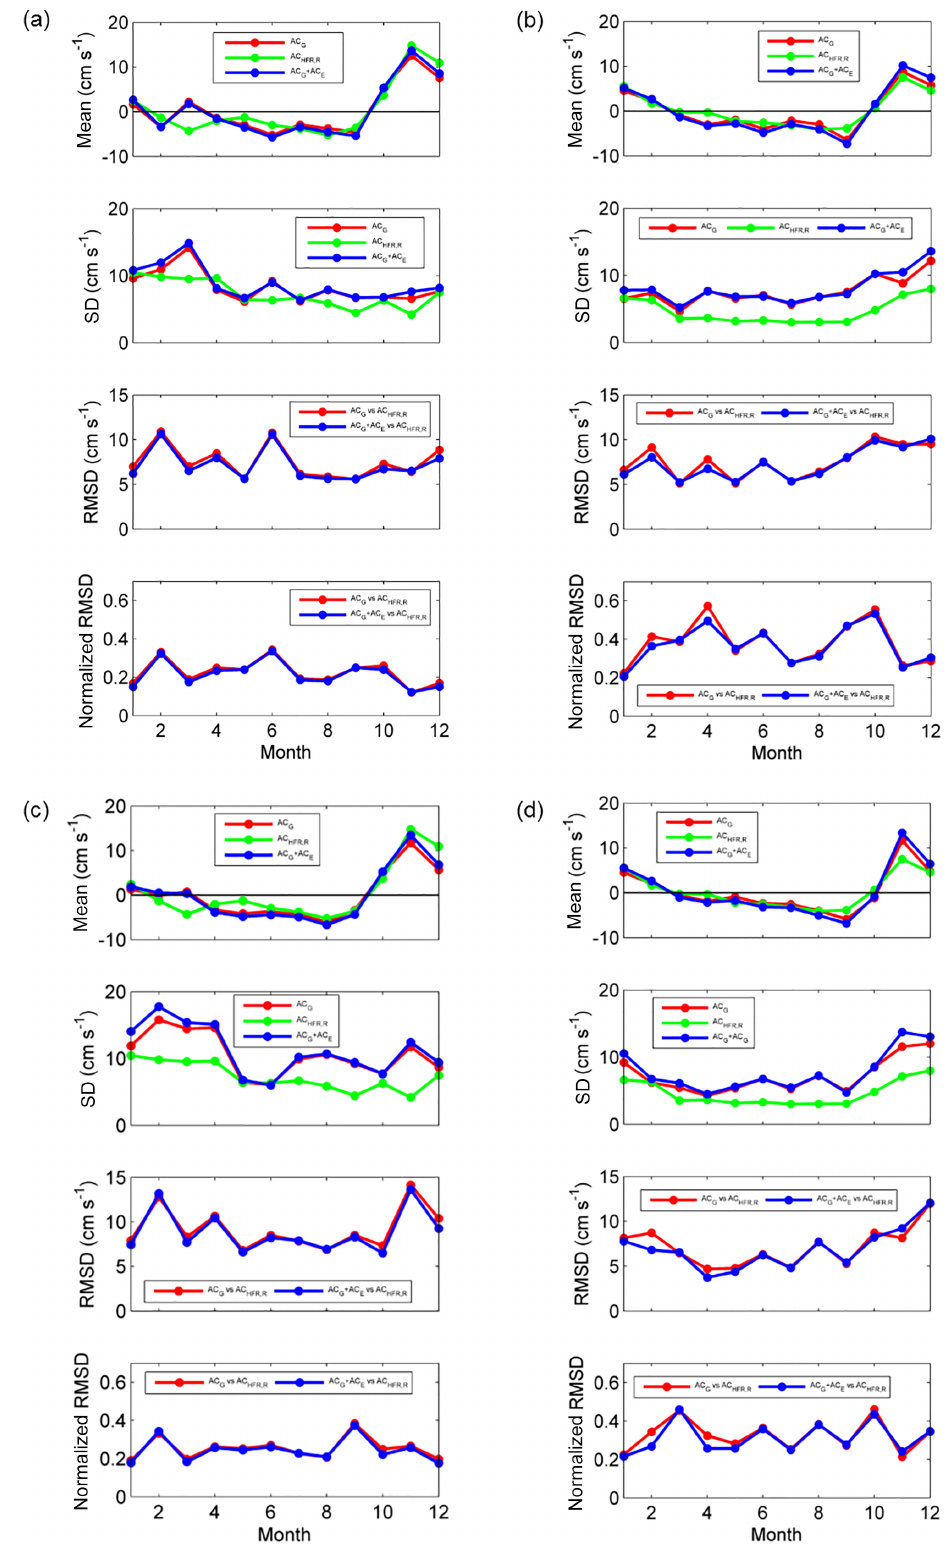
Figure 4. Monthly statistical parameters of the comparison between AC G vs. AC HFR , R and AC G + AC E vs. AC HFR , R at points E R and W R for both altimetry products: (a) CTOH AC G at point W R , (b) CTOH AC G at point E R , (c) CMEMS AC G at point W R , and (d) CMEMS AC G at point E R . The normalized RMSD is the quotient between the RMSD and the values of the corresponding AC HFR , R